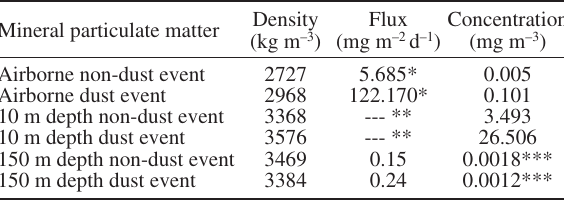
Table 3. – Mean density, lithogenic flux and concentration of particles in airborne and seawater samples. * calculated assuming a settling rate of 1.4 cm s –1 (Neuer et al. 2004); ** not calculated because the high turbulence at 10 m depth makes the settling